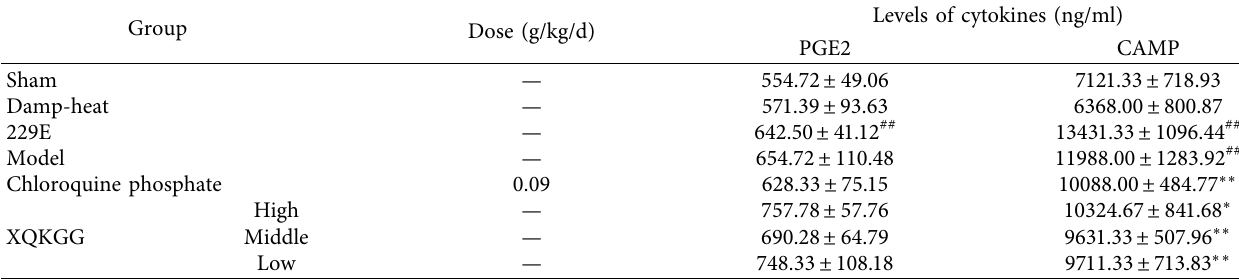
Table 4: Comparison of cytokines in hypothalamus tissue of mice in groups ( n �